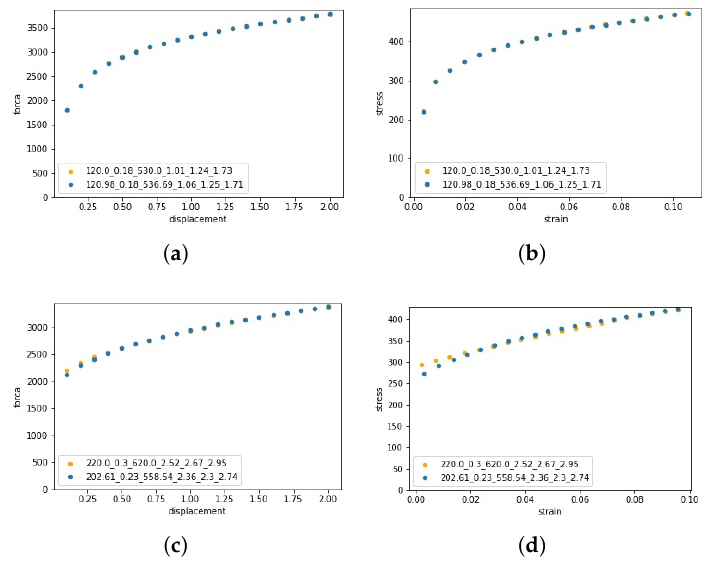
Figure 13. ( a ) Force displacement and ( b ) stress-strain curves for the cruciform test case 1. ( c ) Force displacement and ( d ) stress-strain curves for cruciform test case 3. The values depicted in the legends are the reference and predicted model